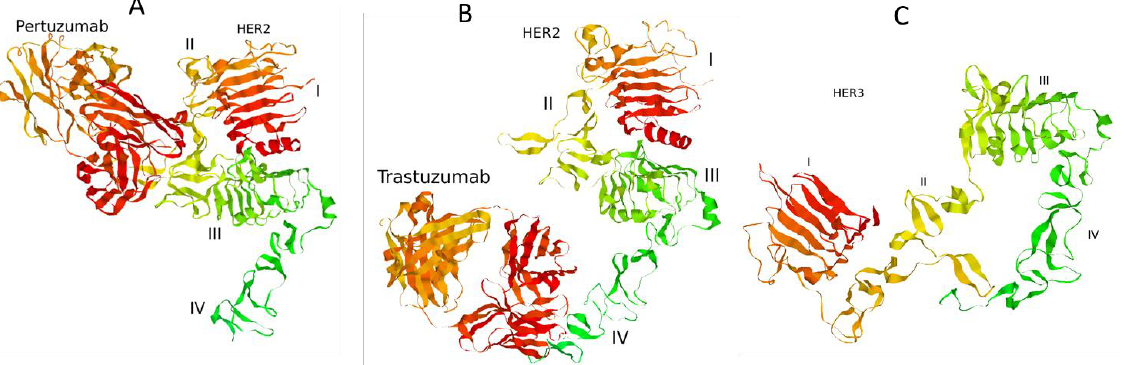
Figure 2. Complexes of the extracellular domain of HER2 receptor with pertuzumab ( A ) and trastuzumab ( B ). The structure of the extracellular domain of HER3 receptor ( C ). 3D structures of the proteins were retrieved from Protein Data Bank [43]: PDB codes 1S78 ( A ), 1N8Z ( B ), and 1M6B ( C